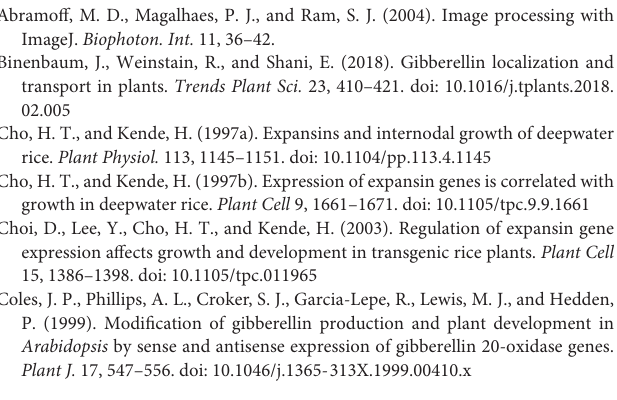
period, and red arrowheads show the sampling time for the experiments. Further details are explained in the Materials and Methods. Supplementary Figure 2 | Growth of tomato plants under negative and positive DIF treatments. Young tomato seedlings were grown for 7 days under positive and negative DIF treatments. (A) Growth of seedlings. Seedlings of tomato were photographed at 0, 1, 3, 5, and 7 days. Scale bars = 5 cm. (B,C) Hypocotyl and epicotyl length, respectively. (D,E) Hypocotyl and epicotyl diameters, respectively. (F) Cotyledons and true leaves photographed at 7 days after onset of DIF treatments. Scale bars = 5 cm. Data are represented as mean ± SD ( n = 3 or 4). ∗ P < 0.05; ∗∗ P < 0.01 (Student’s t test). + DIF, positive DIF; -DIF, negative DIF. Supplementary Figure 3 | Growth comparison of five tomato cultivars under DIF treatments. Seedlings of five tomato cultivars, Daiki B baria (DaikiB), Rinka, CF momotaro-york (CFMY), Managua RZ (MA), and Reiyo (RYO) were grown for 7 days under positive and negative DIF. (A) Growth of seedlings. Seedlings of tomato were photographed at 7 days. Scale bars = 5 cm. (B,C) Hypocotyl and epicotyl length, respectively. (D,E) Hypocotyl and epicotyl diameter, respectively. Data are shown as boxplots ( n = 3). Cross marks in boxplot indicate the mean values. ∗ P < 0.05; ∗∗ P < 0.01 (Student’s t test). + DIF, positive DIF; -DIF, negative DIF. Supplementary Figure 4 | Concentration of CKs in hypocotyls and epicotyls under positive and negative DIF treatments. Hypocotyls and epicotyls of tomato seedlings grown for 7 days under positive and negative DIF treatments were harvested and subjected to hormone analysis. The concentration of CKs were quantified using liquid chromatography-tandem mass spectrometry. Data are represented as mean ± SD ( n = 3 to 5). tZ, trans -zeatin; tZR, tZ riboside; tZRPs, tZR 5 (cid:48) -phosphates; tZ7G, tZ- 7N -glucoside; tZ9G, tZ- 9N -glucoside; tZOG, tZ- O -glucoside; tZROG, tZR- O -glucoside; iP, N 6 -( (cid:49) 2 -isopentenyl)adenine; iPR, iP riboside; iPRPs, iPR 5 (cid:48) -phosphates; iP7G, iP- 7N -glucoside; iP9G, iP- 9N -glucoside. ∗ P < 0.1; ∗∗ P < 0.05; ∗∗∗ P < 0.01 (Student’s t test). tZRPOG, tZRP- O -glucoside was below the quantification limit. + DIF, positive DIF; -DIF, negative DIF; FW, fresh weight; UQ, under quantification limit. Supplementary Figure 5 | Concentration of CKs in hypocotyls and epicotyls under two different temperatures. Hypocotyls and epicotyls of tomato seedlings grown for 7 days under control and high temperatures were harvested and subjected to hormone analysis. The concentration of CKs were quantified using liquid chromatography-tandem mass spectrometry. Data are represented as mean ± SD ( n = 3 to 5). tZ, trans -zeatin; tZR, tZ riboside; tZRPs, tZR 5 (cid:48) -phosphates; tZ7G, tZ- 7N -glucoside; tZ9G, tZ- 9N -glucoside; tZOG, tZ- O -glucoside; tZROG, tZR- O -glucoside; iP, N 6 -( (cid:49) 2 -isopentenyl)adenine; iPR, iP riboside; iPRPs, iPR 5 (cid:48) -phosphates; iP7G, iP- 7N -glucoside; iP9G, iP- 9N -glucoside. ∗ P < 0.1; ∗∗ P < 0.05; ∗∗∗ P < 0.01 (Student’s t test). tZRPOG, tZRP- O -glucoside was below the quantification limit. CT, control temperature; HT, high temperature; FW, fresh weight; UQ, under quantification